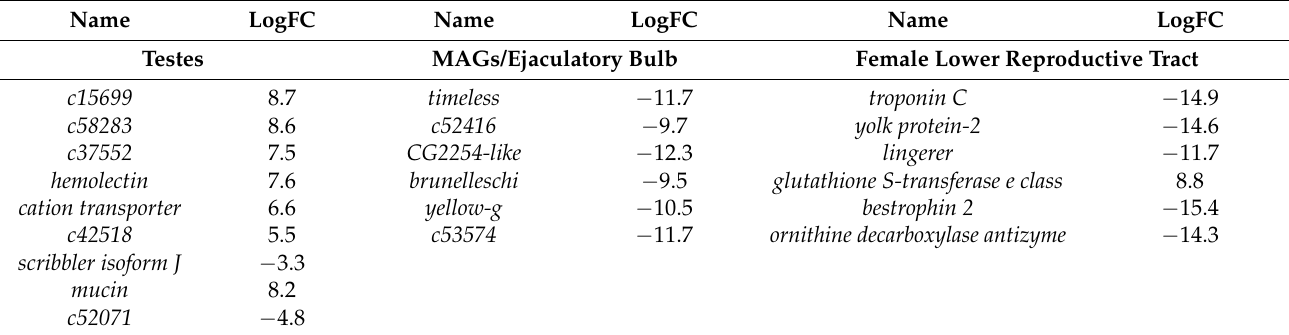
Table 1. List of the differentially expressed genes of the RNAseq analysis selected for validation. The name used is based on their homologue in D. melanogaster . Genes that have no hits are presented with their transcript name. A positive value of logFC of testes, represents the overexpression of the genes in mated flies while negative value of logFC represents the overexpression of the genes in virgin flies. A negative value of logFC of MAGS/ejaculatory bulb or female reproductive tract indicates overexpression of the gene in mated flies while positive logFC value represents overexpression of the gene in virgin flies.